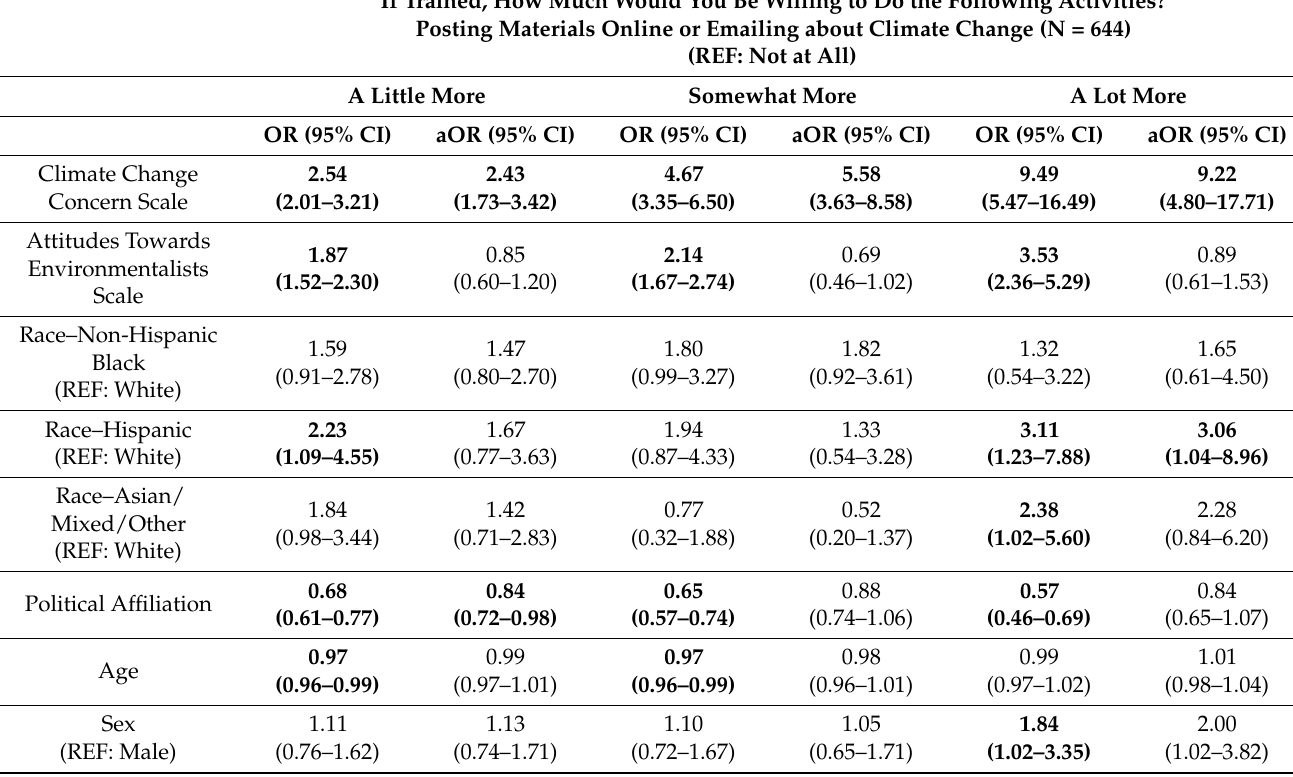
Table 6. Bivariable and multivariable model of willingness to post materials or e-mail about climate change, if